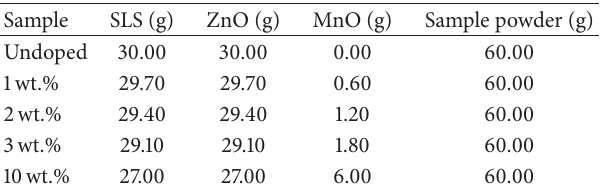
Table 1: Chemical compositions of ( SLS 0.5 ZnO 0.5 ) 𝑦 ( MnO ) 1−𝑦